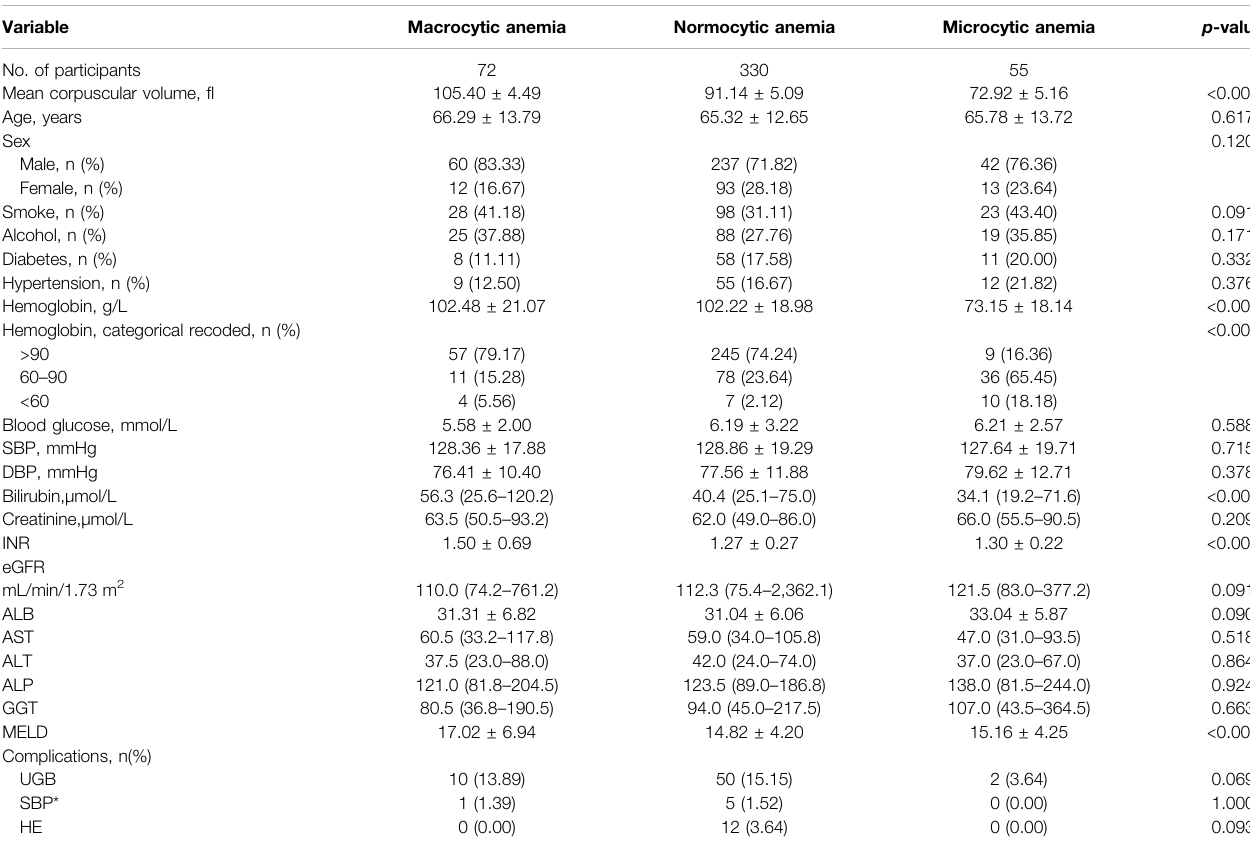
TABLE 1 | Baseline Characteristics of participants ( N (cid:1)